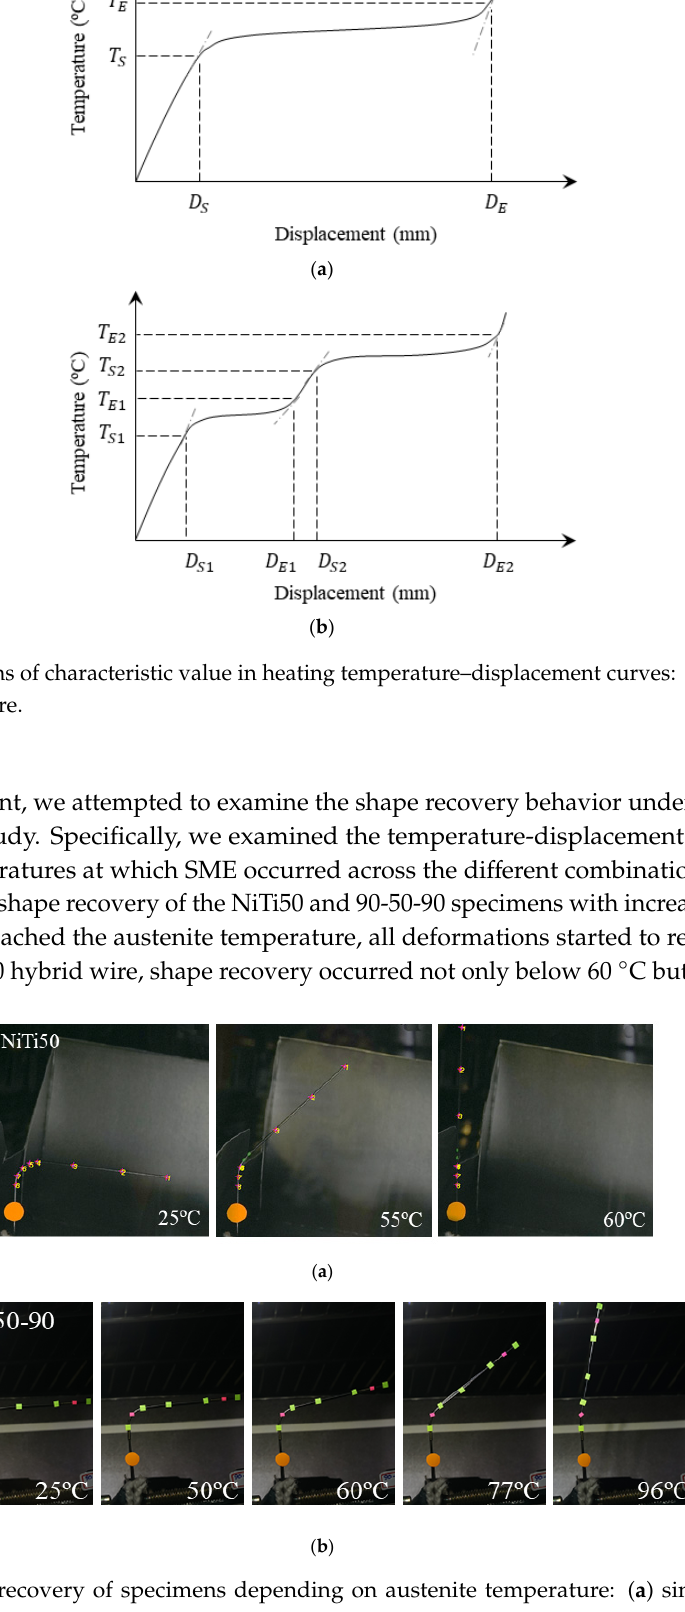
Figure 6. Chamber temperature variation.